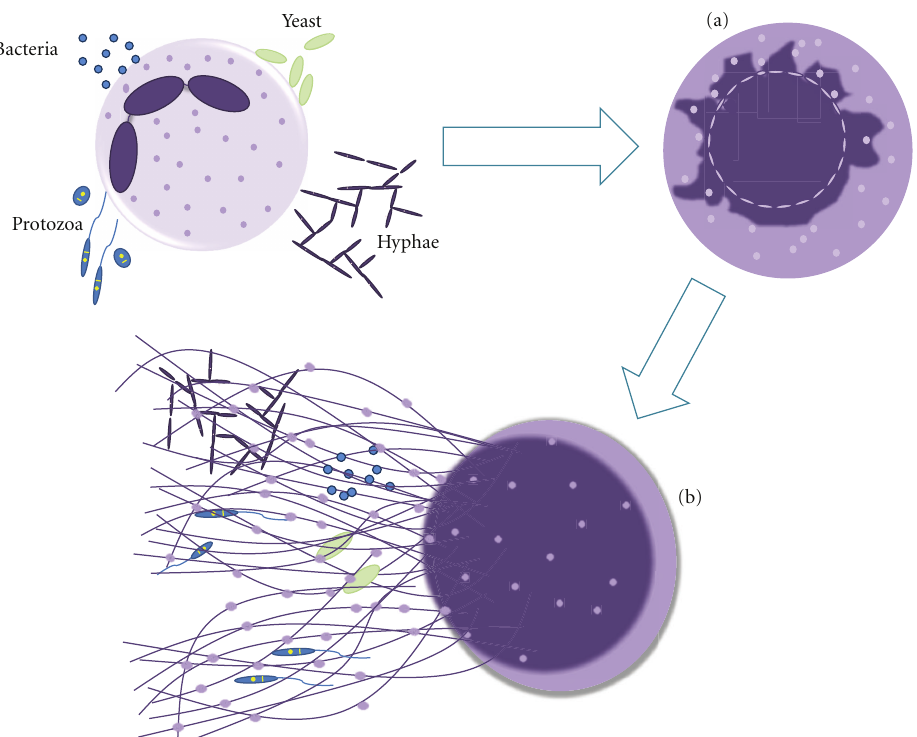
Figure 1: Mechanism of Neutrophil Extracellular Traps release. Neutrophils are stimulated by contact with bacteria, protozoan, fungi (yeast and hyphae forms) or their products (not shown), leading to: (a) ultrastructural alterations of nuclear shape with chromatin decondensation, swollen and fragmentation of the nuclear membrane, which allow the association of granules and cytoplasmic proteins with the chromatin, and (b) release of extracellular structures consisting of a DNA-backbone, decorated with histones, neutrophil granular and cytoplasmatic proteins (NETs), which ensnare and kill